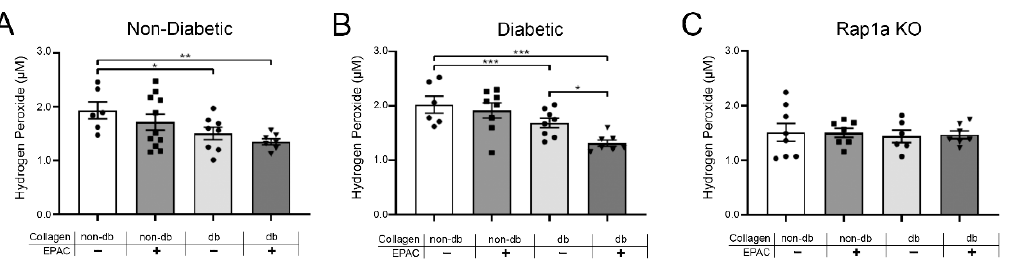
Figure 7. Endogenous AGEs and EPAC treatment caused a decrease in hydrogen peroxide in cardiac fibroblast with functional RAGE and Rap1a. ( A ) Non-diabetic, ( B ) diabetic, and ( C ) Rap1a KO cardiac fibroblasts (P1) were cultured on either non-diabetic or diabetic collagen. Fibroblasts were treated with EPAC (100 µ M) for 24 h, followed by isolation of protein lysates. Hydrogen peroxide concentration ( µ M) was determined for each sample and mean ± SEM were depicted in the graphs ( n = 6–11). Statistical significance was determined by a one-way ANOVA followed by a Fisher’s Protected Least Significant Difference post hoc (* p < 0.05, ** p < 0.01, and *** p <